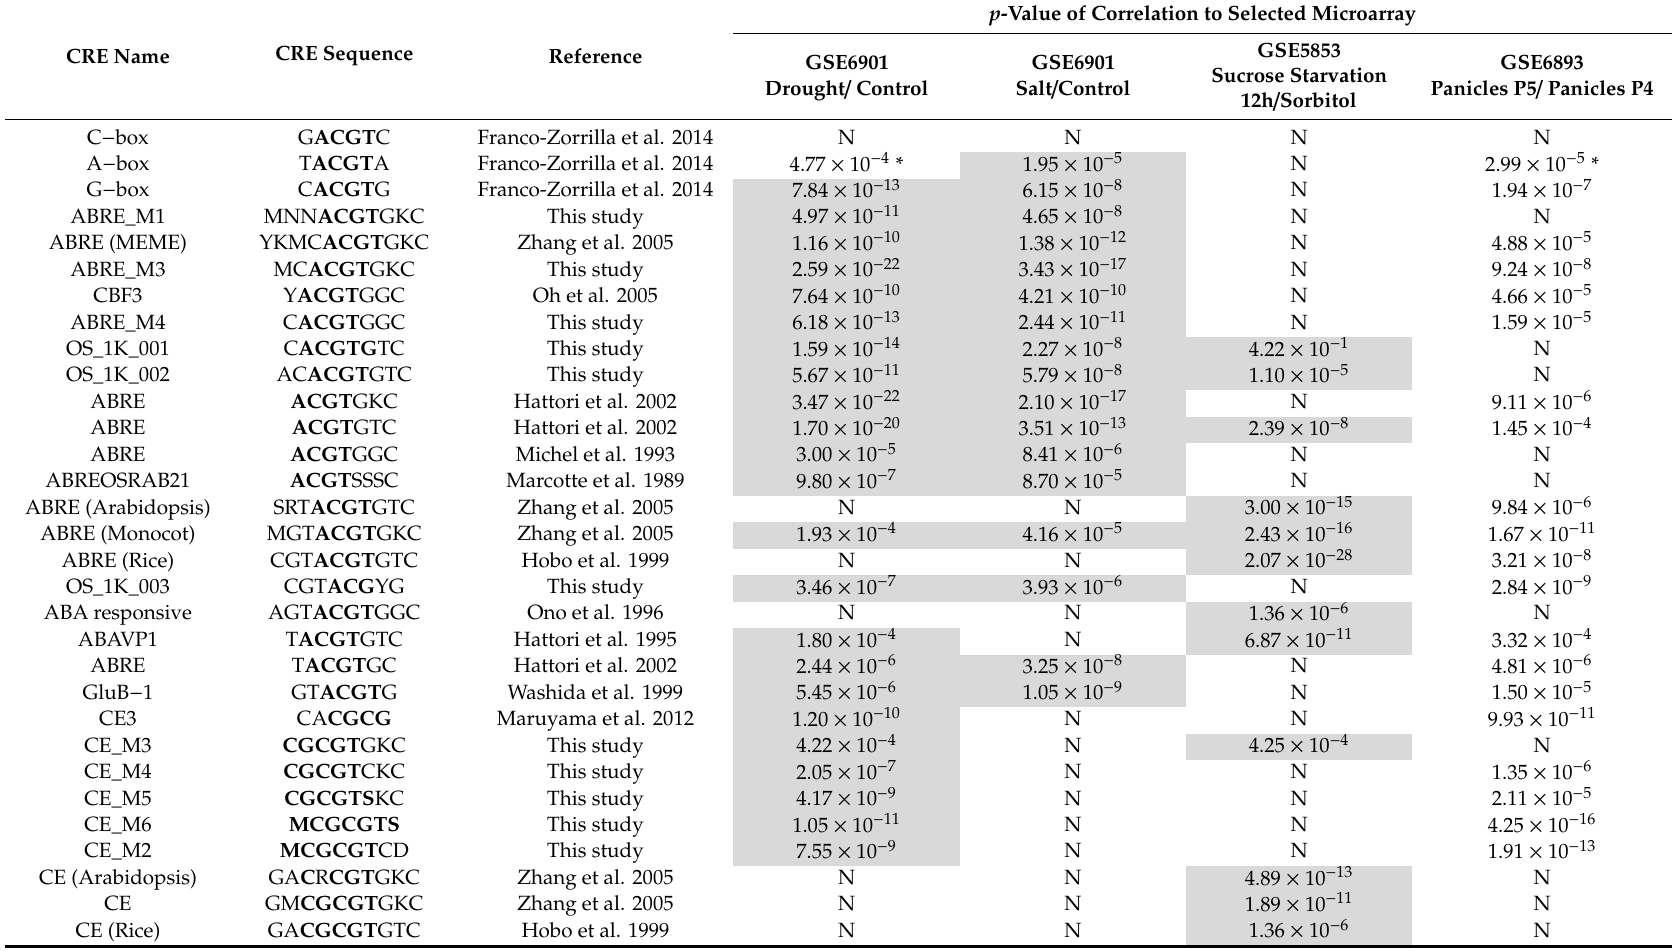
Table 1. Known or predicted CREs with abscisic acid responsive element (ABRE) core and coupling element (CE) and their correlation to related